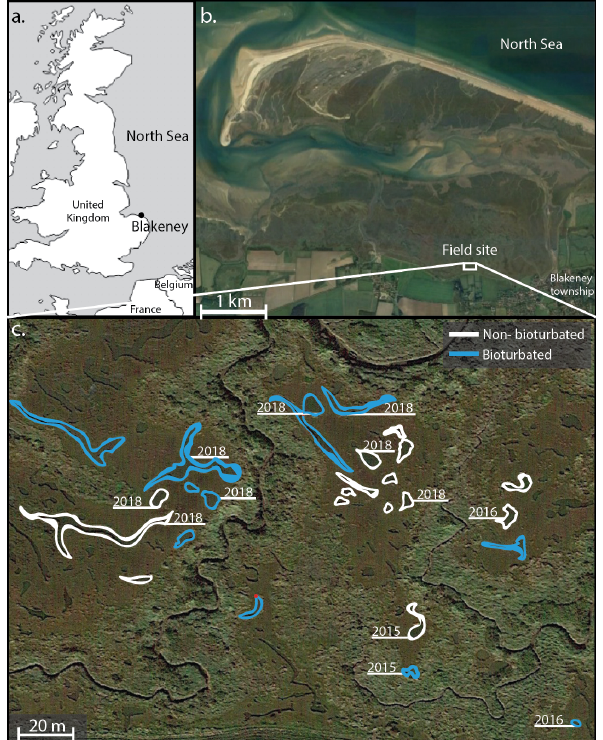
Figure 1. Overview of the field site in the Blakeney salt marsh sys- tem, UK. Sampled ponds are outlined in white (non-bioturbated) and blue (bioturbated), with ponds where sediment cores taken de- noted with the sampling year. Coordinates of the sampled ponds are given in Table A1. (b, c) Map data © Google Maps